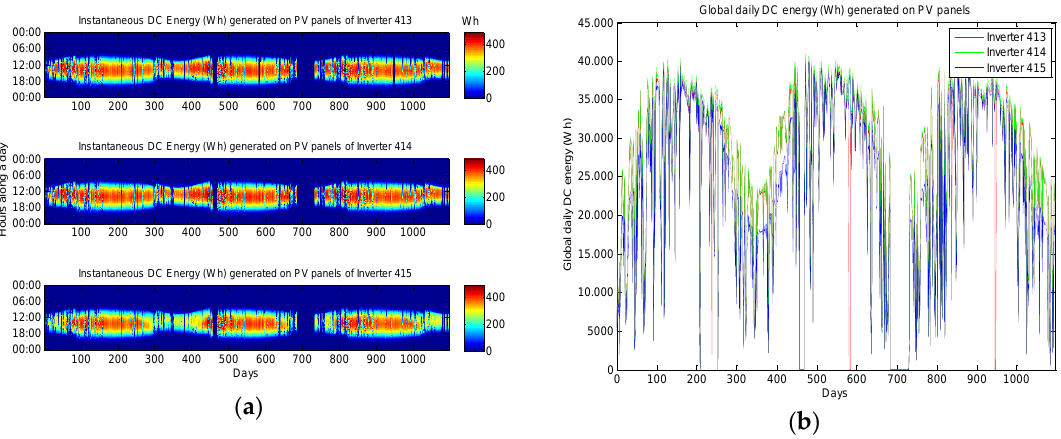
Figure 5. Instantaneous DC energy generated in the PV arrays connected to inverters registered from 1 January 2011 to 31 December 2013: ( a ) instantaneous values, during 24 h a day; and ( b ) total daily values.